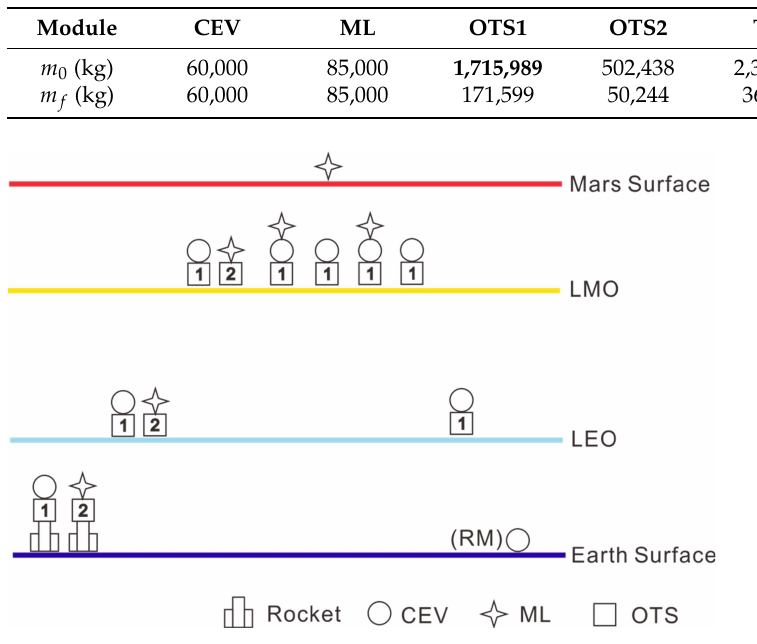
Figure 11. Schematic of Architecture-2.